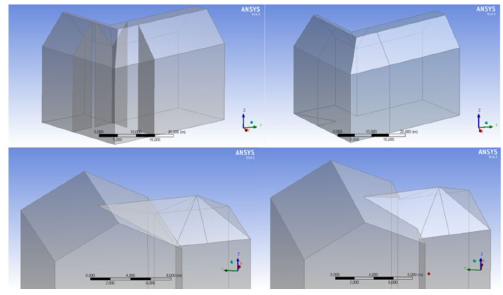
Figure 2. Geometry optimization operations on typical LoD2 building models. Top: removing interior faces. Bottom: resolving